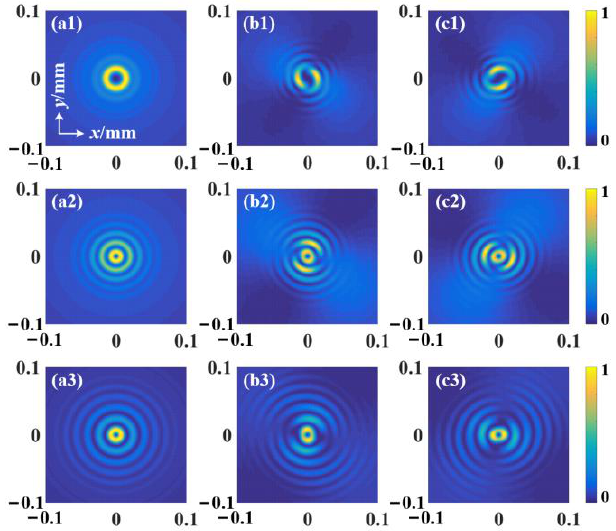
Figure 5. Normalized intensity distributions on the focal plane under different crystal lengths. The first, second, and third columns correspond to the intensity distributions of the total field, the x -polarized component, and the y -polarized component, respectively. The first ( a1 , b1 , c1 ), second ( a2 , b2 , c2 ), and third ( a3 , b3 , c3 ) rows correspond to L = 10 mm, 20 mm and 30 mm, respectively.